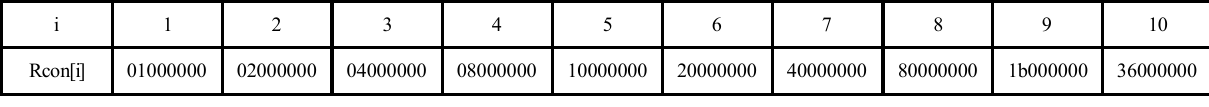
TABLE 1. ROUND CONSTANT (RCON)